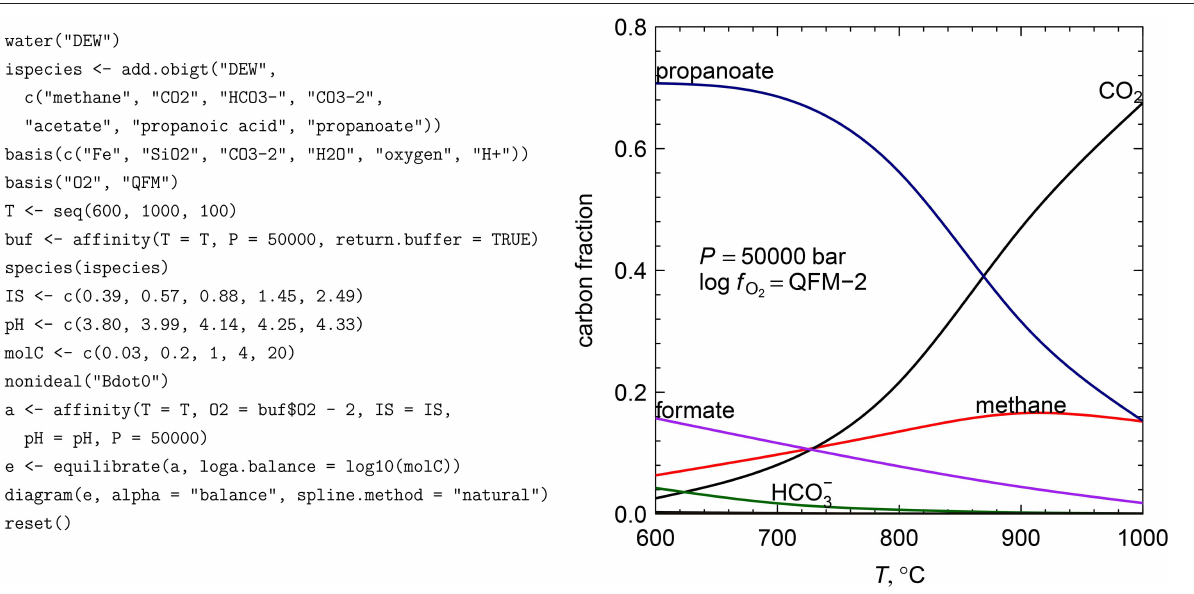
FIGURE 6 | Speciation calculation for aqueous organic species whose thermodynamic properties are calculated using the Deep Earth Water model (Sverjensky et al., 2014a ). The logarithm of oxygen fugacity (log f O2 ) is set to 2 units below the quartz-fayalite-magnetite (QFM) buffer. See text for more details about the calculation. The R script shown here is simplified for clarity; the complete script, which includes code to adjust the colors and labels, is available (Dick, 2019).